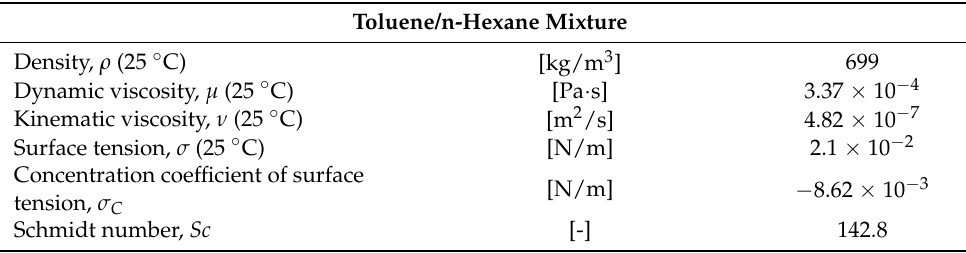
Table 1. Physical properties of toluene/n-hexane (0.24/0.76)